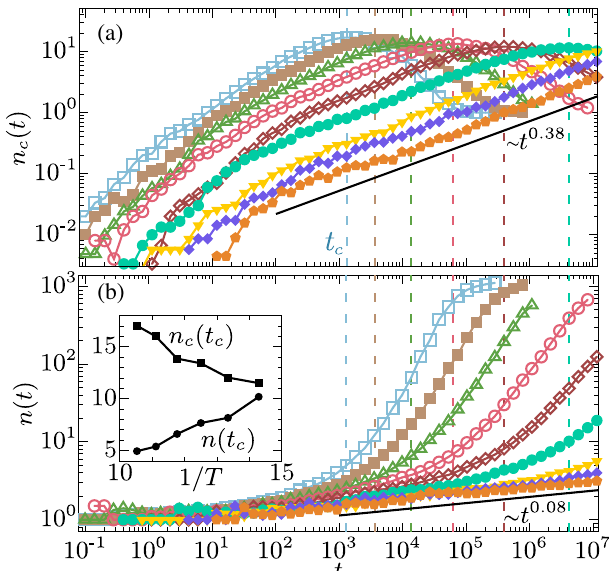
FIG. 9. Statistical analysis of relaxed clusters in 3D. (a) Average t Þ of mobile particles for temperatures as in number of clusters n c ð Fig. 1(a). Dashed lines indicate the time t at which n is c c maximum. At low temperature, the number of clusters grows as a power law (line) with exponent 0.38. (b) Average number of mobile particles n ð t Þ per cluster, with a slow power-law growth t Þ and indicated as a guide to the eye. Inset: average number n c ð size n ð t Þ of clusters at t ¼ t as a function of the inverse c